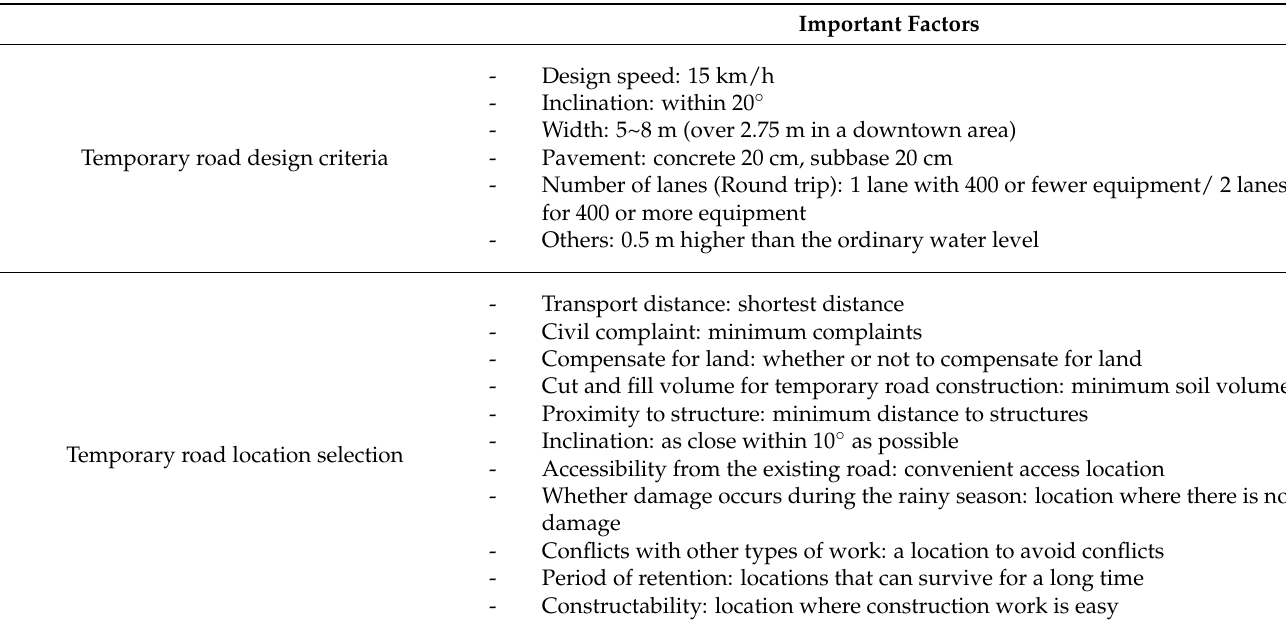
Figure 3. Information on interviewee. Table 1. Elements for a temporary work road